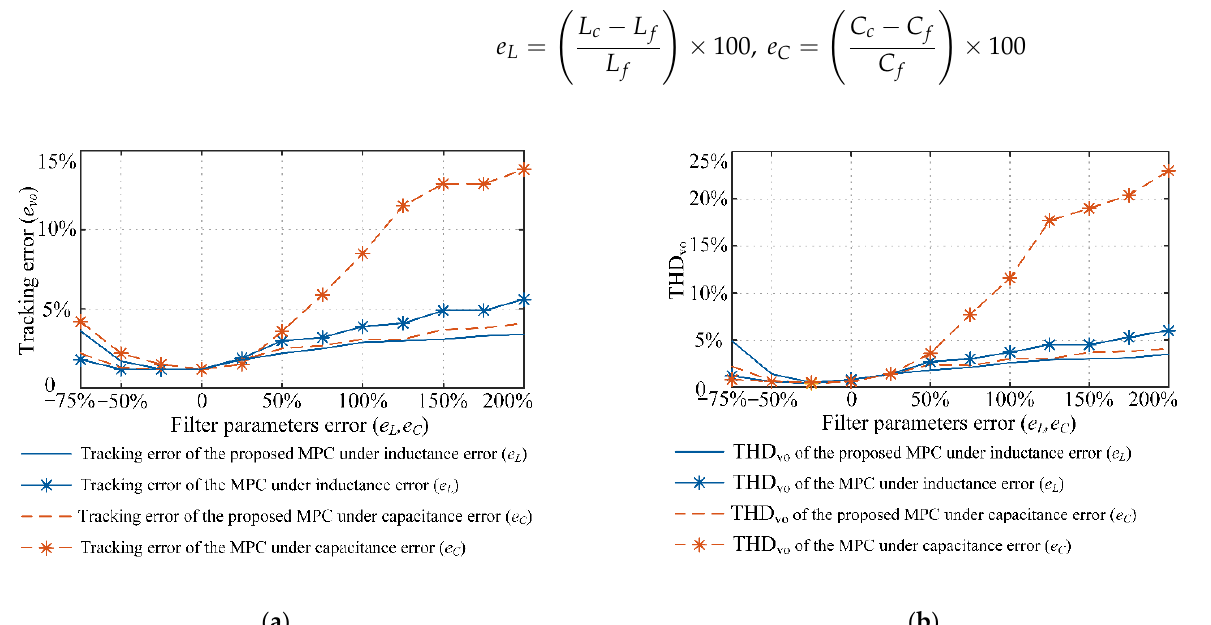
Figure 8. Simulation results showing robustness analysis of the proposed adaptive MPC and conventional MPC against the filter parameters uncertainties, ( a ) voltage tracking error, ( b ) total harmonic distortion (THD vo ).